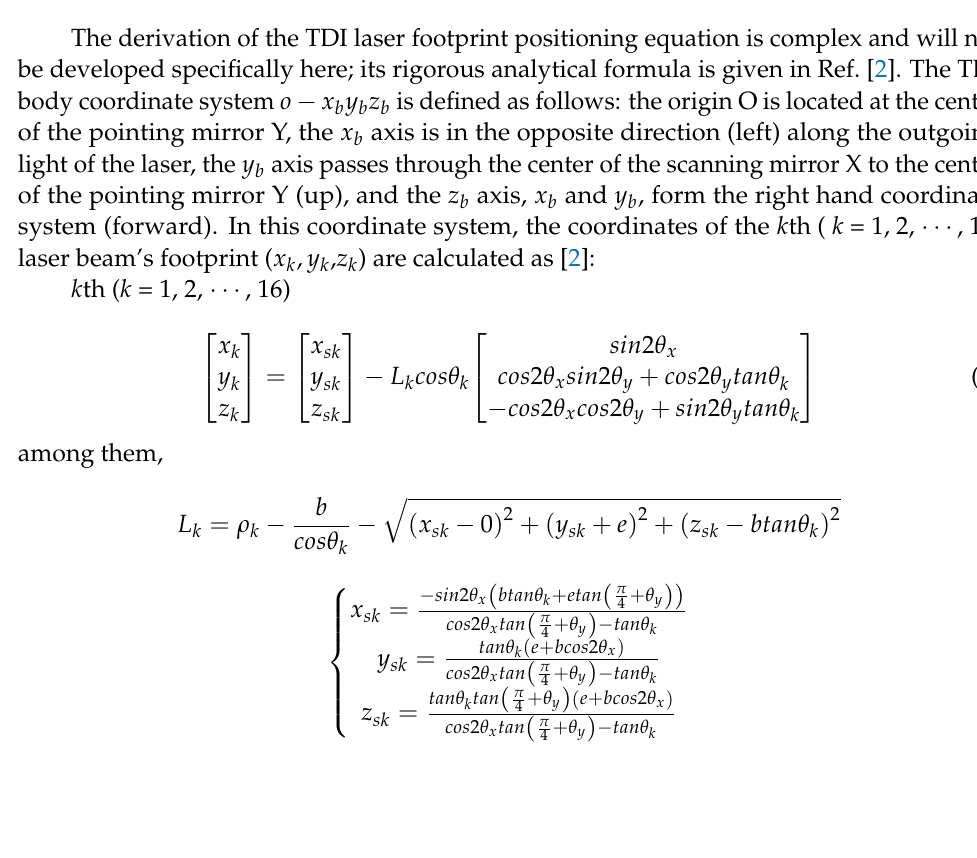
Figure 1. TDI dual galvanometer scanning principle. From point S, 16 laser beams are instantaneously emitted to the scanning mirror X (the 16 laser beams are coplanar), they are reflected by the scanning mirror X and then reach the pointing mirror Y, then fly to the target area after the second reflection. The scanning mirror X and the pointing mirror Y are perpendicular to each other. o − x b y b z b is the TDI body coordinate system, b is the distance from the laser emission point to the scanning mirror X, and e is the distance from the scanning mirror X center to the pointing mirror Y